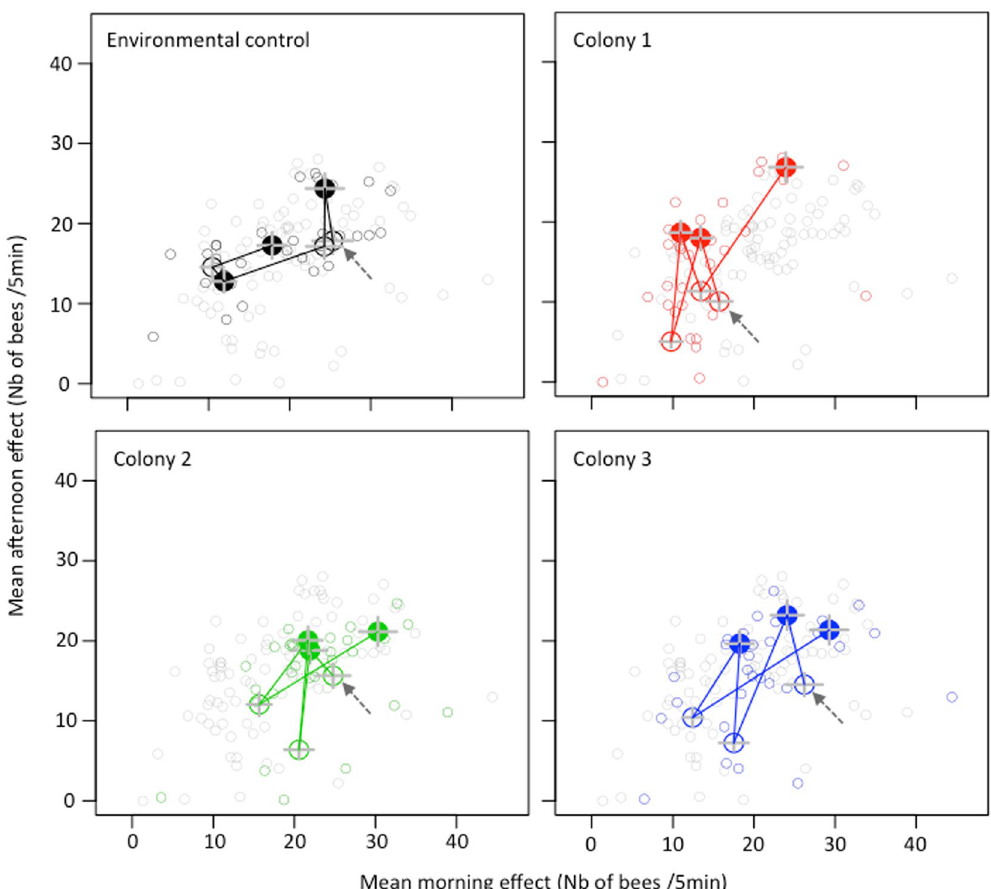
Figure 2. Mean morning effects versus mean afternoon effects estimated from the autoregressive conditional Poisson model. Each small circle gives the morning effect (abscissa) and the afternoon effect (ordinate) estimated for a specific day and colony (computed number of exits every 5 min in the morning and afternoon, respectively). In each panel, small coloured circles (in black, red, green or blue, depending on the panel) correspond to daily morning and afternoon effects of the colony of interest, whereas grey small circles correspond to daily morning and afternoon effects of the three other colonies. In each panel, large circles represent the average effects of the colony of interest for 5-day periods without SHW. Large dots represent the average effects for 5-day periods with SHW. Lines linking the large circles and dots represent jumps from a 5-day period to the following 5-days period. Arrows indicate the first 5-day periods of the experiment without SHW (large circle), which is followed by a 5-day periods with SHW (large dot) and so on. For experimental colonies, large dots (SHW + periods) were consistently above large circles (SHW − periods), showing an increase in colony activity under SHW in the